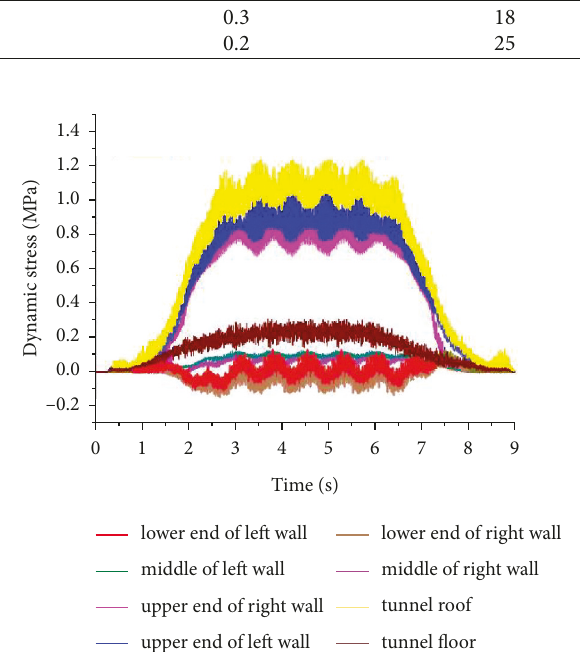
Figure 9: Time-history curve of dynamic compressive stress at each part of the left tunnel cross section.